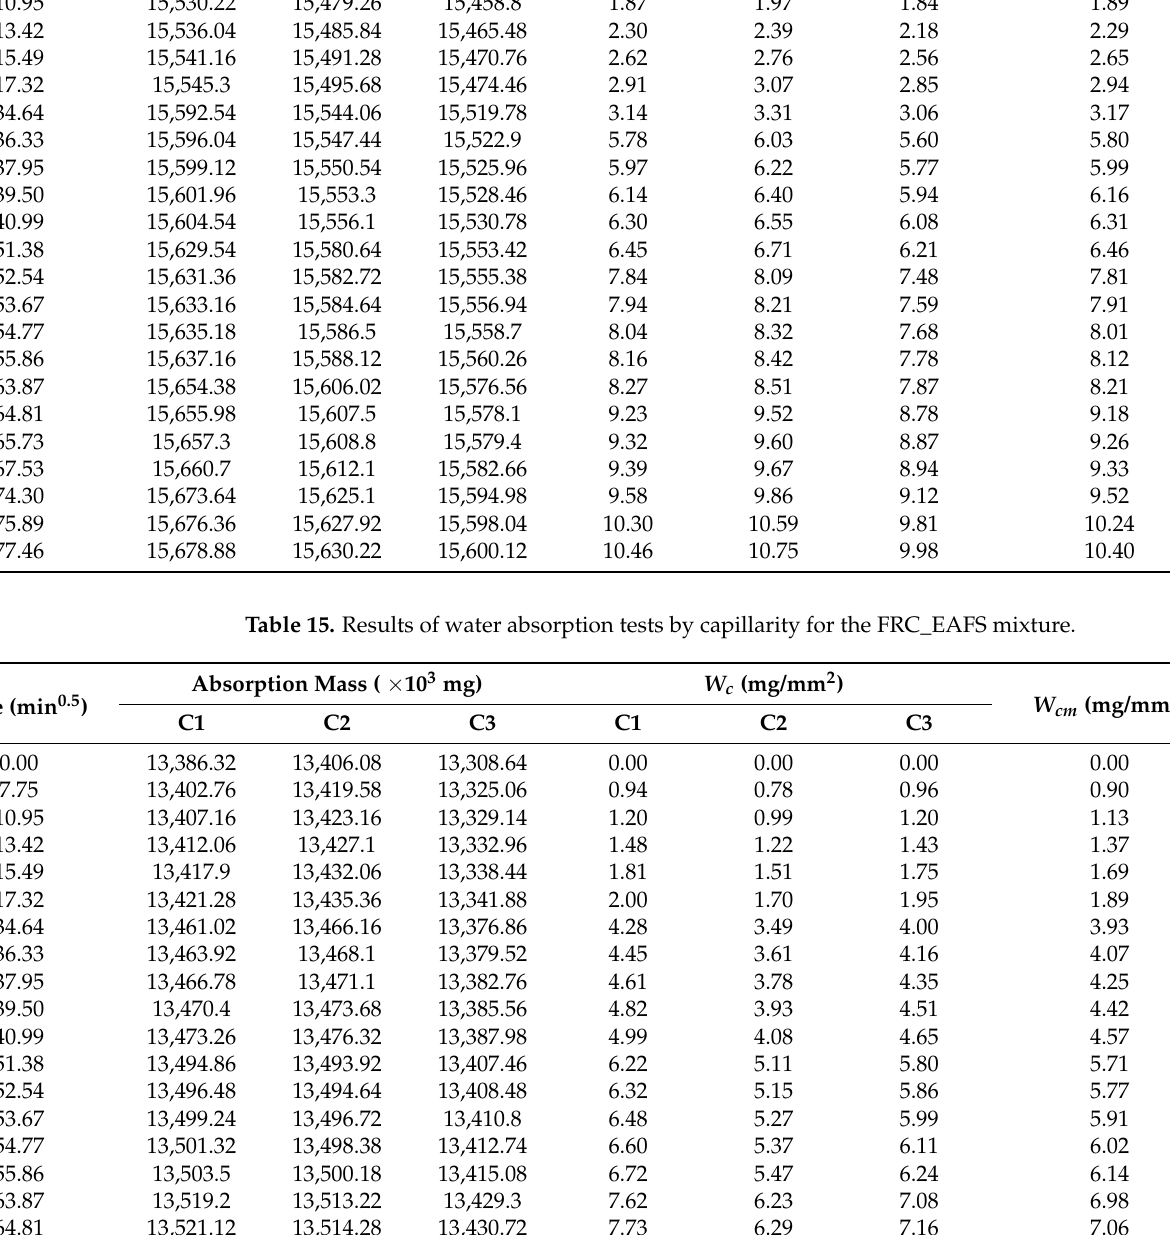
Table 14. Results of water absorption tests by capillarity for the EAFS8D1 mixture.